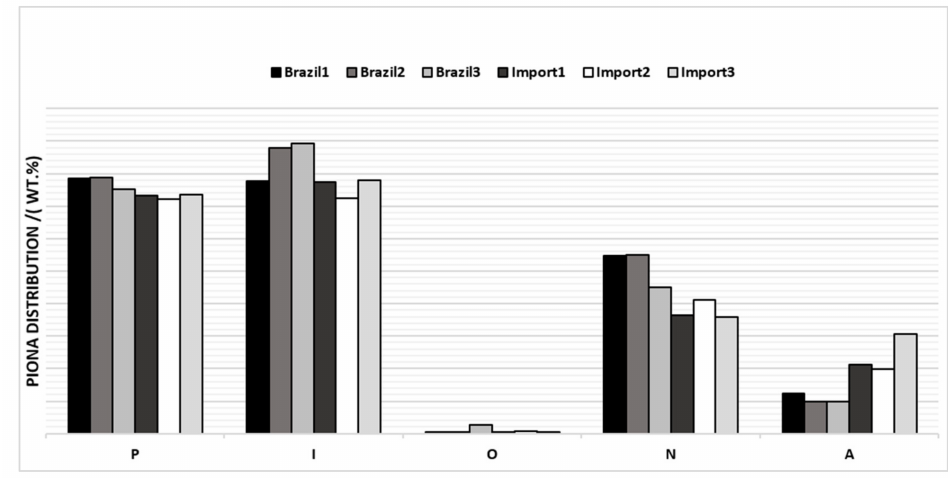
Figure 3. PIONA of naphtha’s samples by origin.